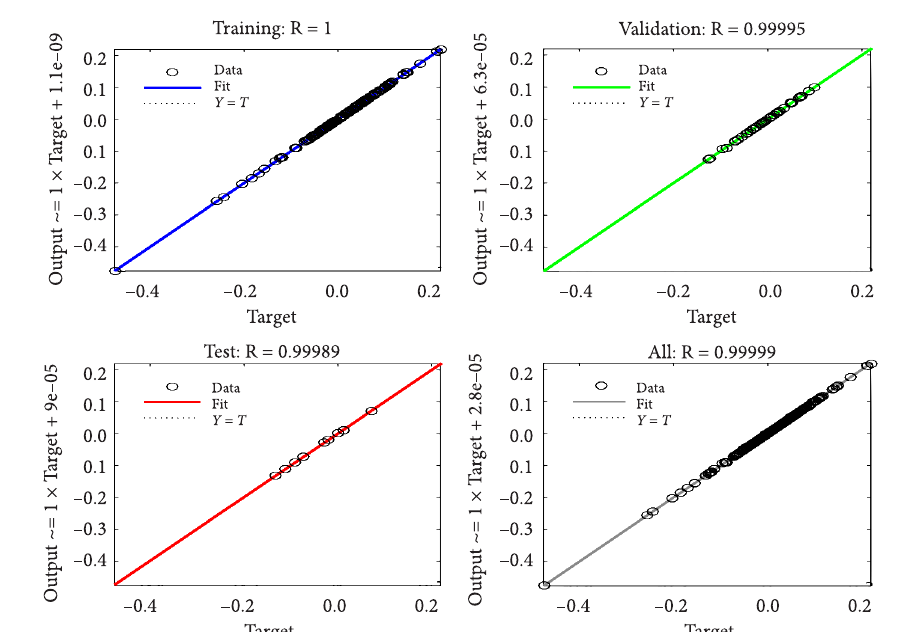
Figure 1. FF5F based Regression Analysis for High Beta